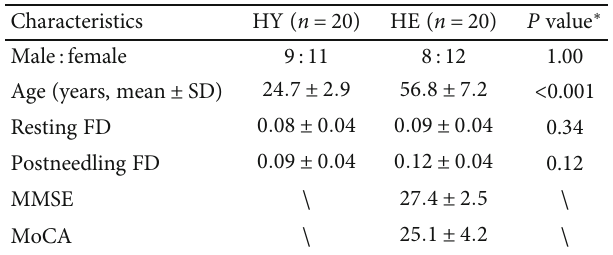
Table 1: Characteristics of the subjects in healthy youth and elder groups ∗